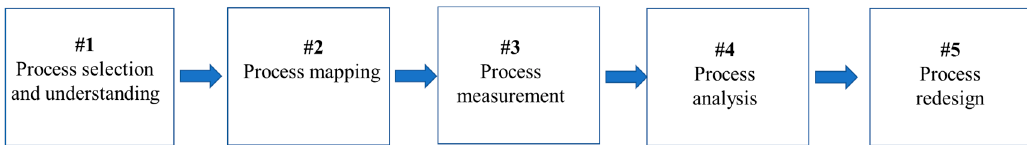
Figure 1. Process innovation framework.